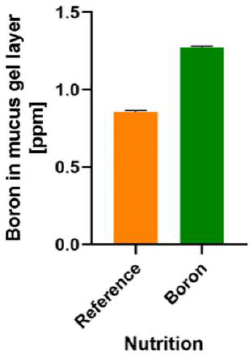
Figure 1. Boron detection in a rat’s colonic mucus gel layer. Reference: normal diet [106]. Boron: CaFB (NOB) supplemented diet. Boron detection was performed by UHPLC/MS [107] (Part S1). CaFB: calcium fructoborate; NOB: naturally organic boron; UHPLC/MS: ultra-high-performance liquid chromatography/mass spectrometry.